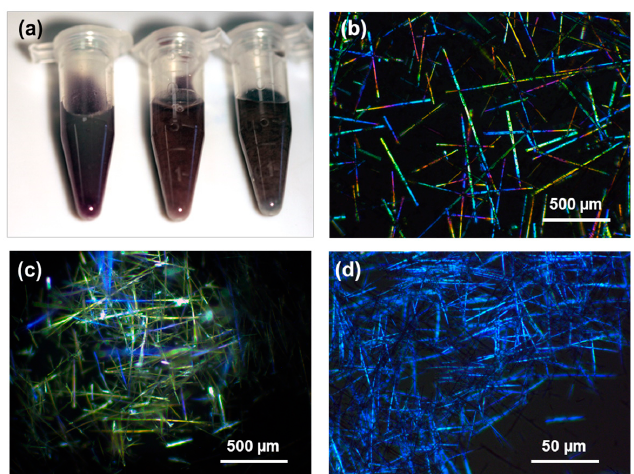
Figure 2. ( a ) Photograph of salt derivative templates. From left to right Pt 2 − : Pt 2+ : Cu 2+ ratios are